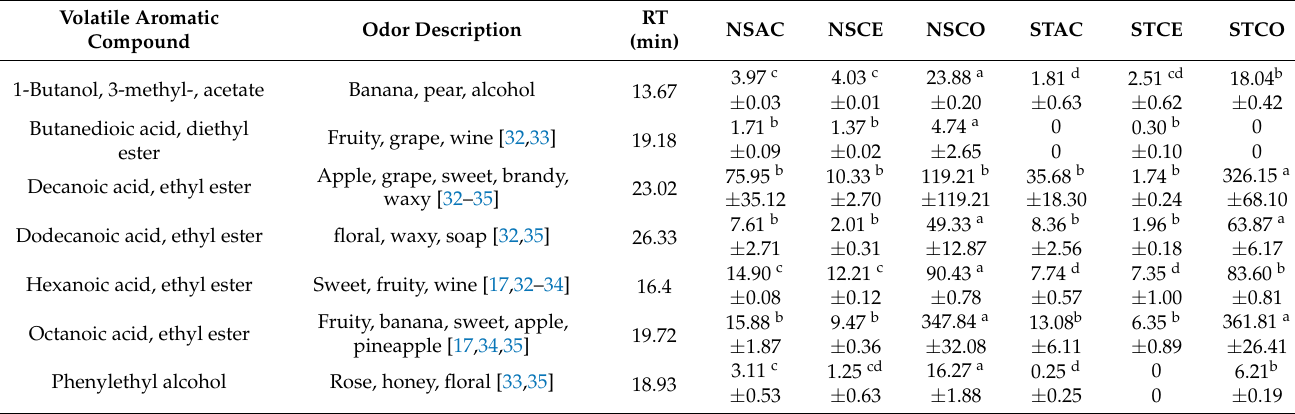
Table 3. Mean values of the peak areas for the volatile aroma compounds detected from the GC-MS analysis (top) and their standard error (bottom), as well as their aroma descriptions and retention times. All values are in scientific notation 10 5